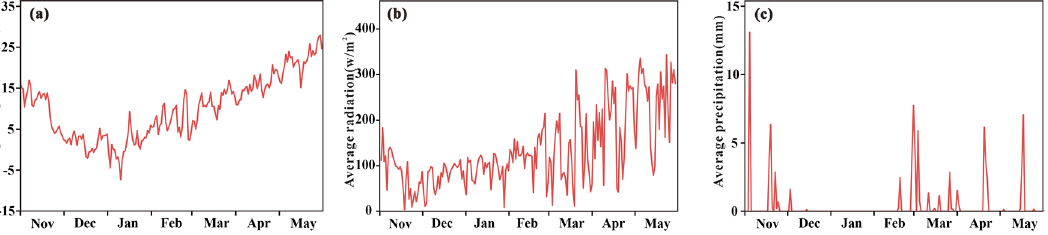
Figure 2. Meteorological data for the whole wheat crop period 2020–2021. ( a ) Average daily temperature, ( b ) average daily radiation, and ( c ) average daily precipitation.